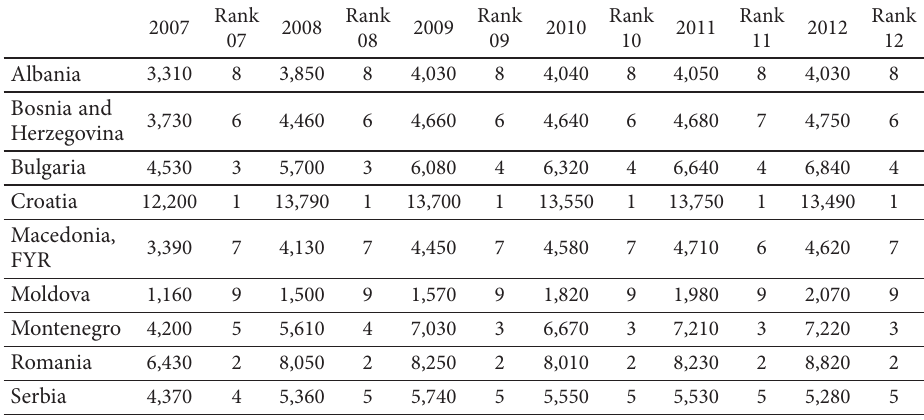
Note : In the Table ranking is done among the selected countries, and the authors have ranked them from 1 (the most developed) to 9 (the least developed). Source : The World Bank Data